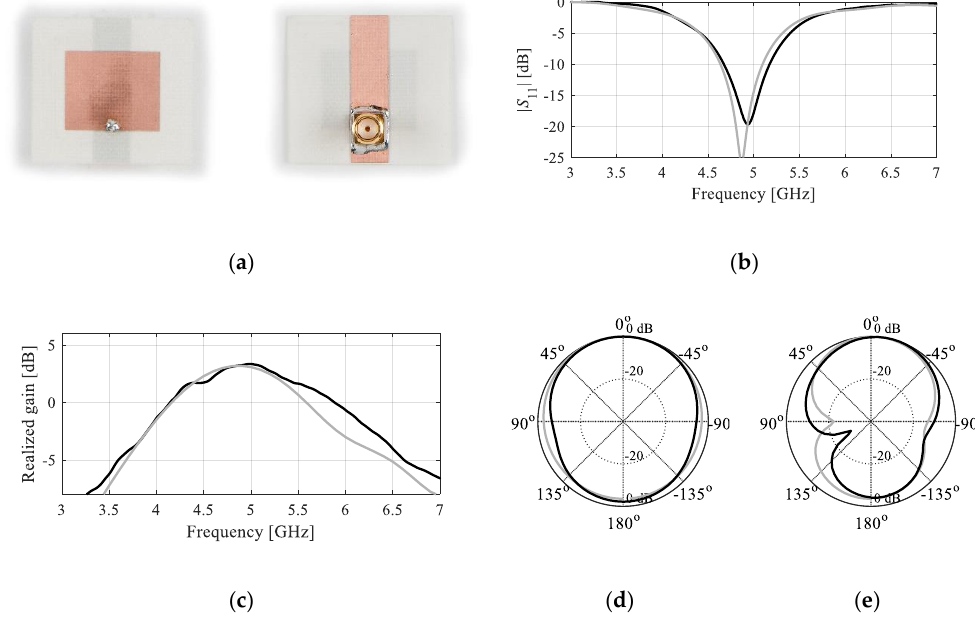
Figure 15. Antenna of Figure 11 optimized for f 0 = 4.8 GHz,  r = 3.38 and h = 0.51 mm, implemented